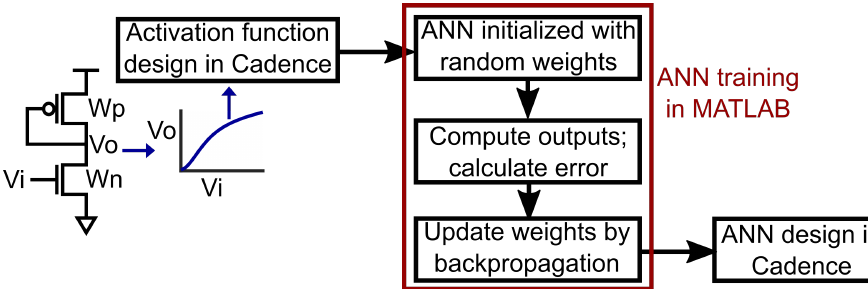
Figure 3. Design methodology employed for proposed cancer